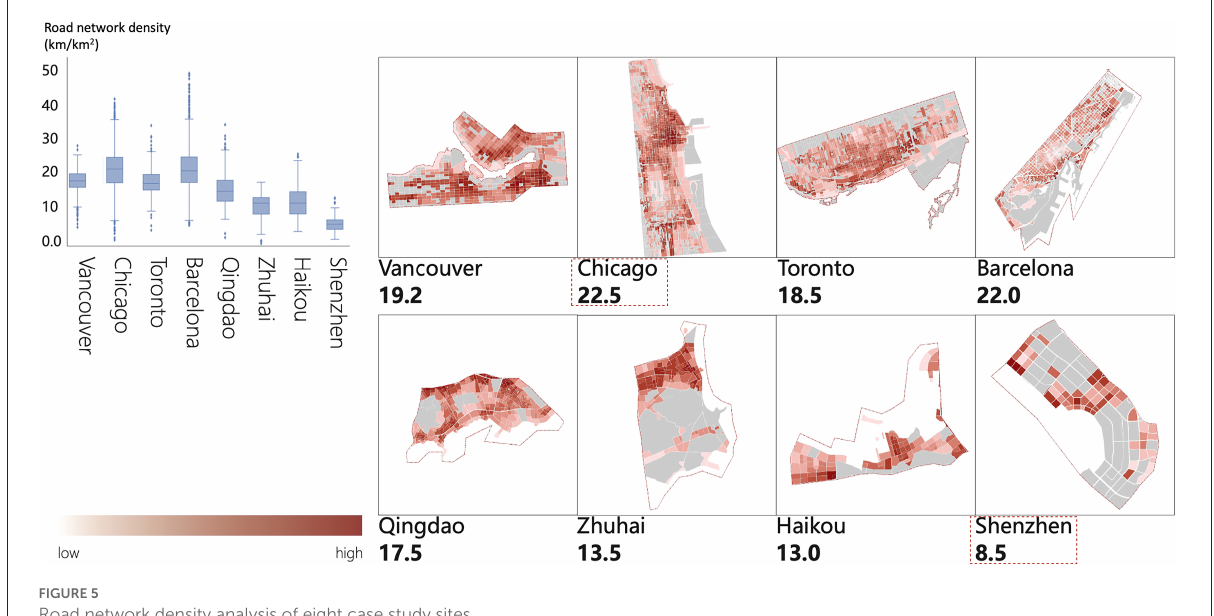
FIGURE5 Road network density analysis of eight case study sites.